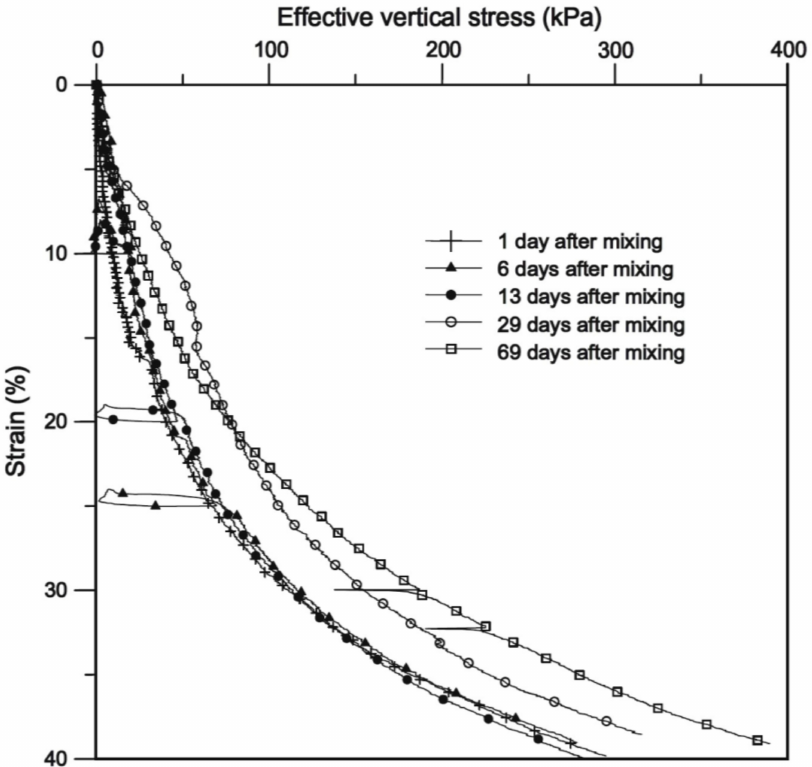
Figure 4. Oedometer test results on silica gel samples kept underwater at 8 ◦ C with unloading- reloading paths ([56] with